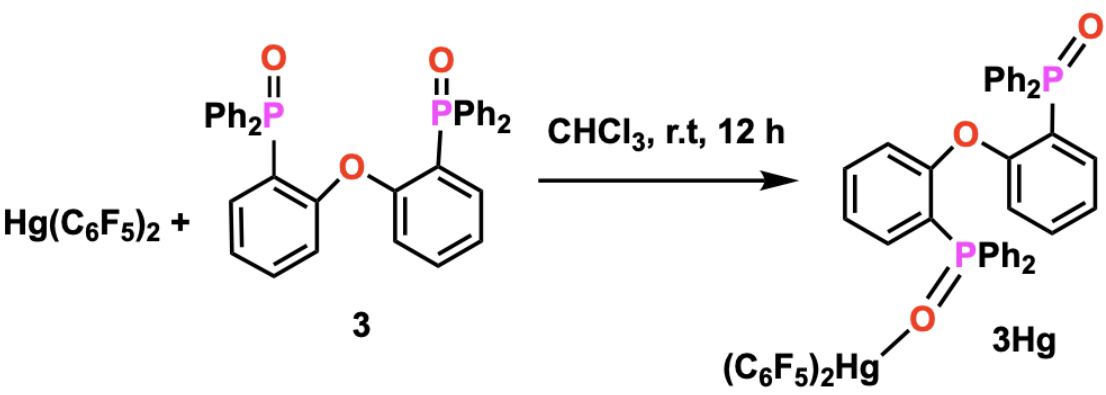
Scheme 4. Synthesis of [Hg(C 6 F 5 ) 2 {2-PPh 2 (O)C 6 H 4 } 2 O] ( 3Hg ).